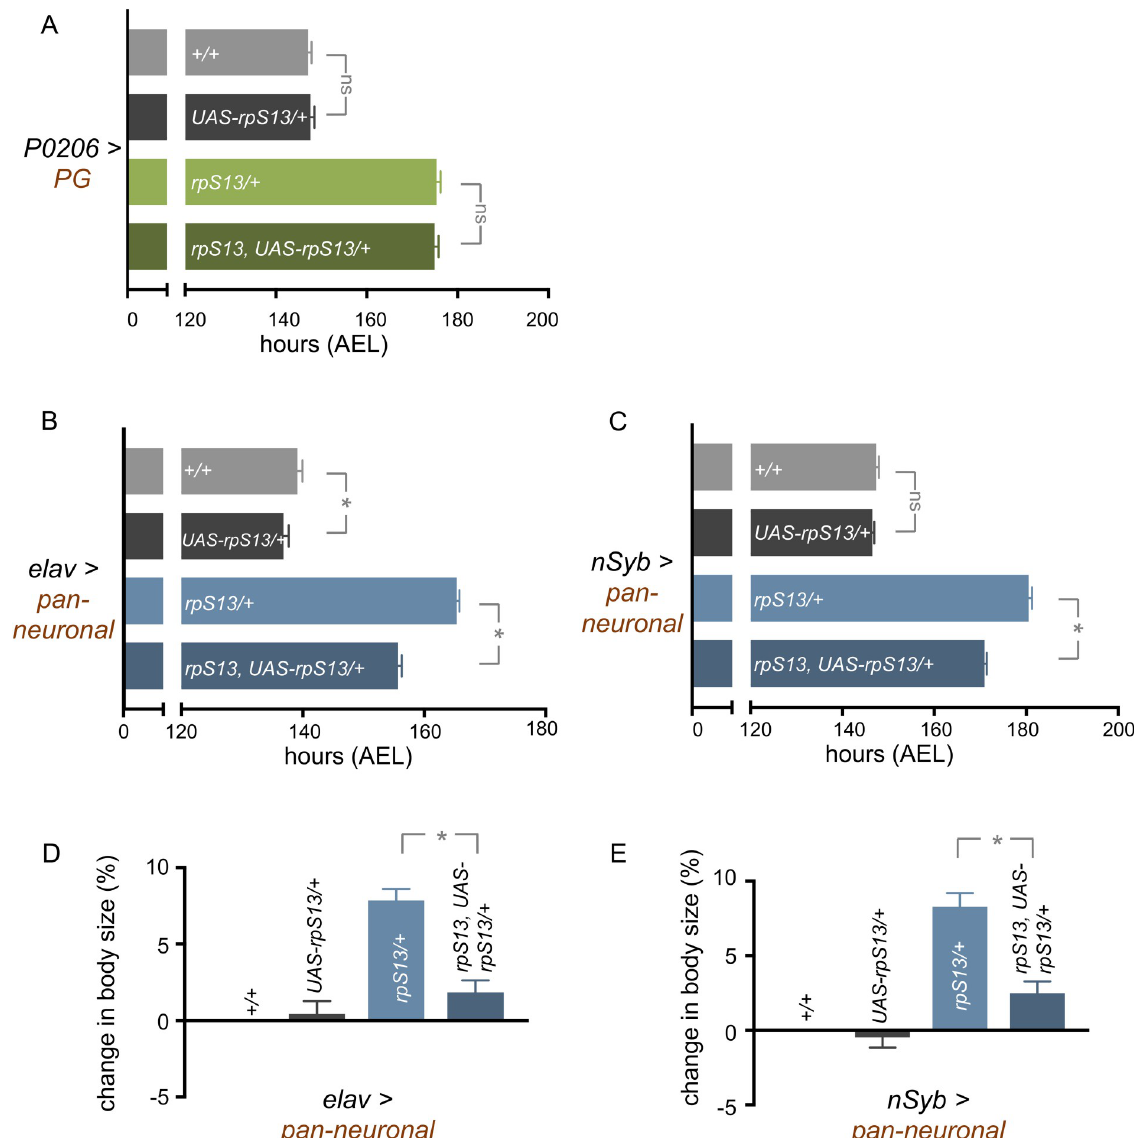
Fig 3. rpS13 re-expression in neurons partially reverses the rpS13/+ developmental delay. (A) Time to pupation of +/+ and rpS13/+ larvae with or without UAS-rpS13 expression in the prothoracic gland using P0206-Gal4 . Data are presented as +/- SEM. ns = not significant, Mann- Whitney U test. n = 95 ( +/ +), 95 ( UAS-rpS13/+ ), 98 ( rpS13/+ ), 87 ( rpS13 , UAS-rpS13/+ ). (B) Time to pupation of +/+ and rpS13/+ larvae with or without UAS-rpS13 expression using the pan-neuronal driver, elav-Gal4 . Data are presented as +/- SEM. ns = not significant, � p < 0.05, Mann-Whitney U test. +/+ n = 180, rpS13/+ n = 167, UAS-rpS13/+ n = 182, rpS13 , UAS-rpS13/+ n = 226. (C) Time to pupation of +/+ and rpS13/+ larvae with or without UAS-rpS13 expression using the pan-neuronal driver, nSyb-Gal4 . Data are presented as +/- SEM. ns = not significant, � p < 0.05, Mann-Whitney U test. +/+ n = 182, rpS13/+ n = 180, UAS-rpS13/+ n = 190, rpS13 , UAS-rpS13/+ n = 176. (D) Pupal volume of +/+ and rpS13/+ animals with or without UAS-rpS13 expression using the pan-neuronal driver, elav-Gal4 . Data are presented as +/- SEM. � p < 0.05, Student’s t-test. +/+ n = 313, rpS13/+ n = 468, UAS-rpS13/+ n = 456, rpS13 , UAS-rpS13/+ n = 475. (E) Pupal volume of +/+ and rpS13/+ animals with or without UAS-rpS13 expression using the pan-neuronal driver, nSyb-Gal4 . Data are presented as +/- SEM. � p < 0.05, Student’s t-test. +/+ n = 588, rpS13/+ n = 484, UAS-rpS13/+ n = 586, rpS13 , UAS-rpS13/+ n = 536. (S3A Fig), but the delayed development in rpS13/+ larvae was unaffected in a dilp8 heterozy- gous mutant background (S3B Fig). We also examined the effects of imaginal disc RpS13 expression on developmental timing in rpS13/+ larvae. We used the esg-Gal4 ts which directs